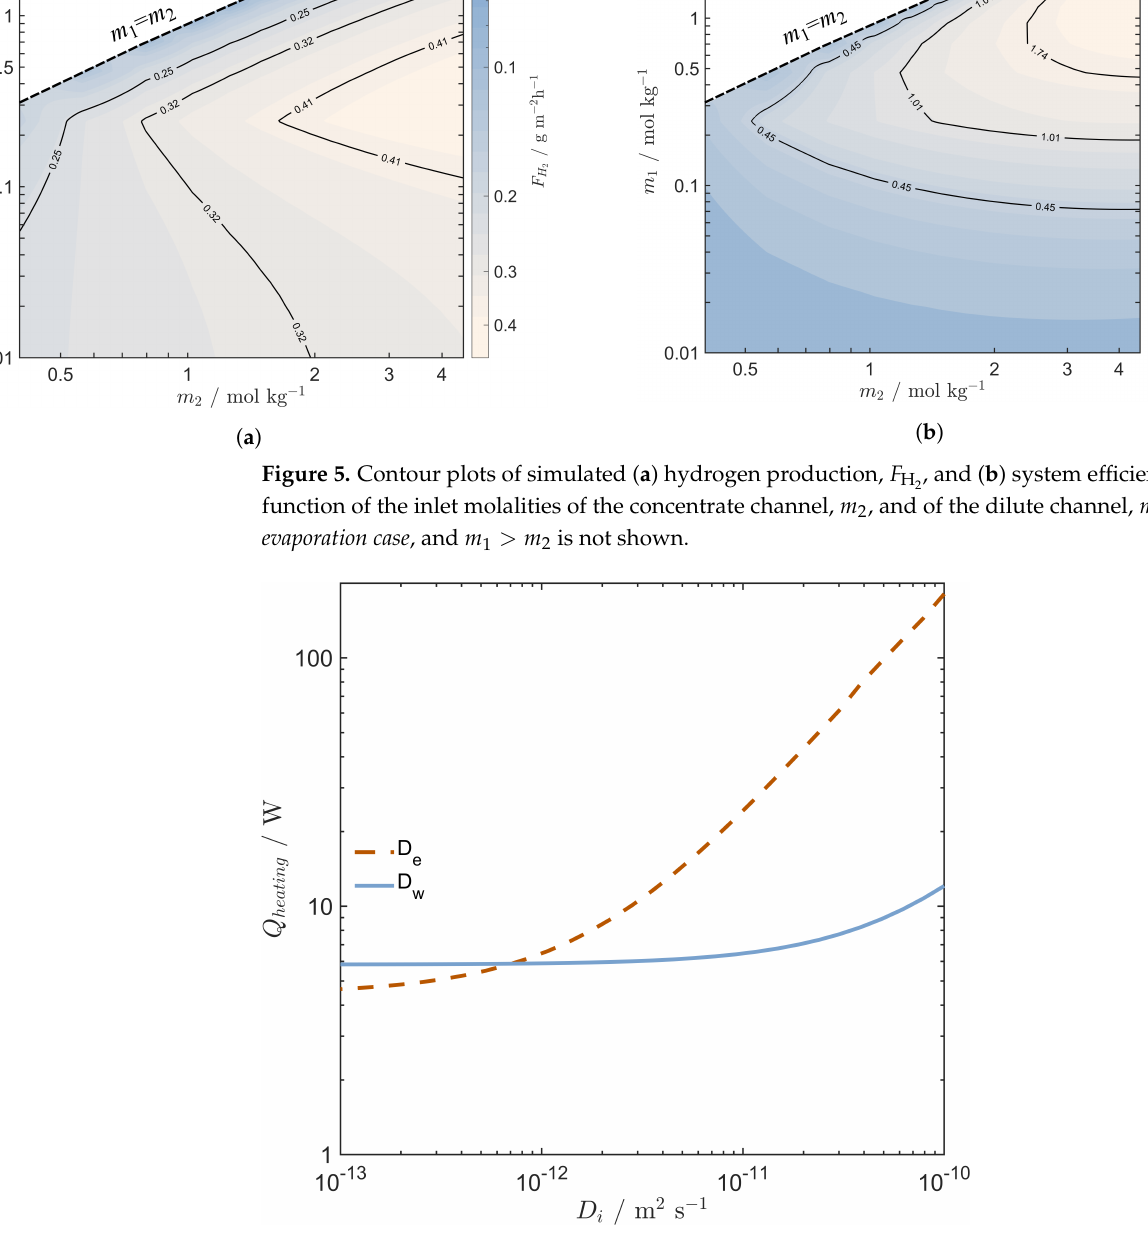
Figure 6. Required heating duty, Q heating , for the evaporation case as function of the diffusion co- efficients. The salt diffusion coefficient is varied with a constant water diffusion coefficient of D w = 1 × 10 − 11 m 2 s − 1 (dashed line, orange), and the water diffusion coefficient is varied with a constant salt diffusion coefficient of D e = 1 × 10 − 12 m 2 s − 1 (solid line, blue). Flow velocity does not have a significant impact on the cell performance if the salt diffusion coefficient is D e = 1 × 10 − 12 m 2 s − 1 , and profiles of molality, voltage and